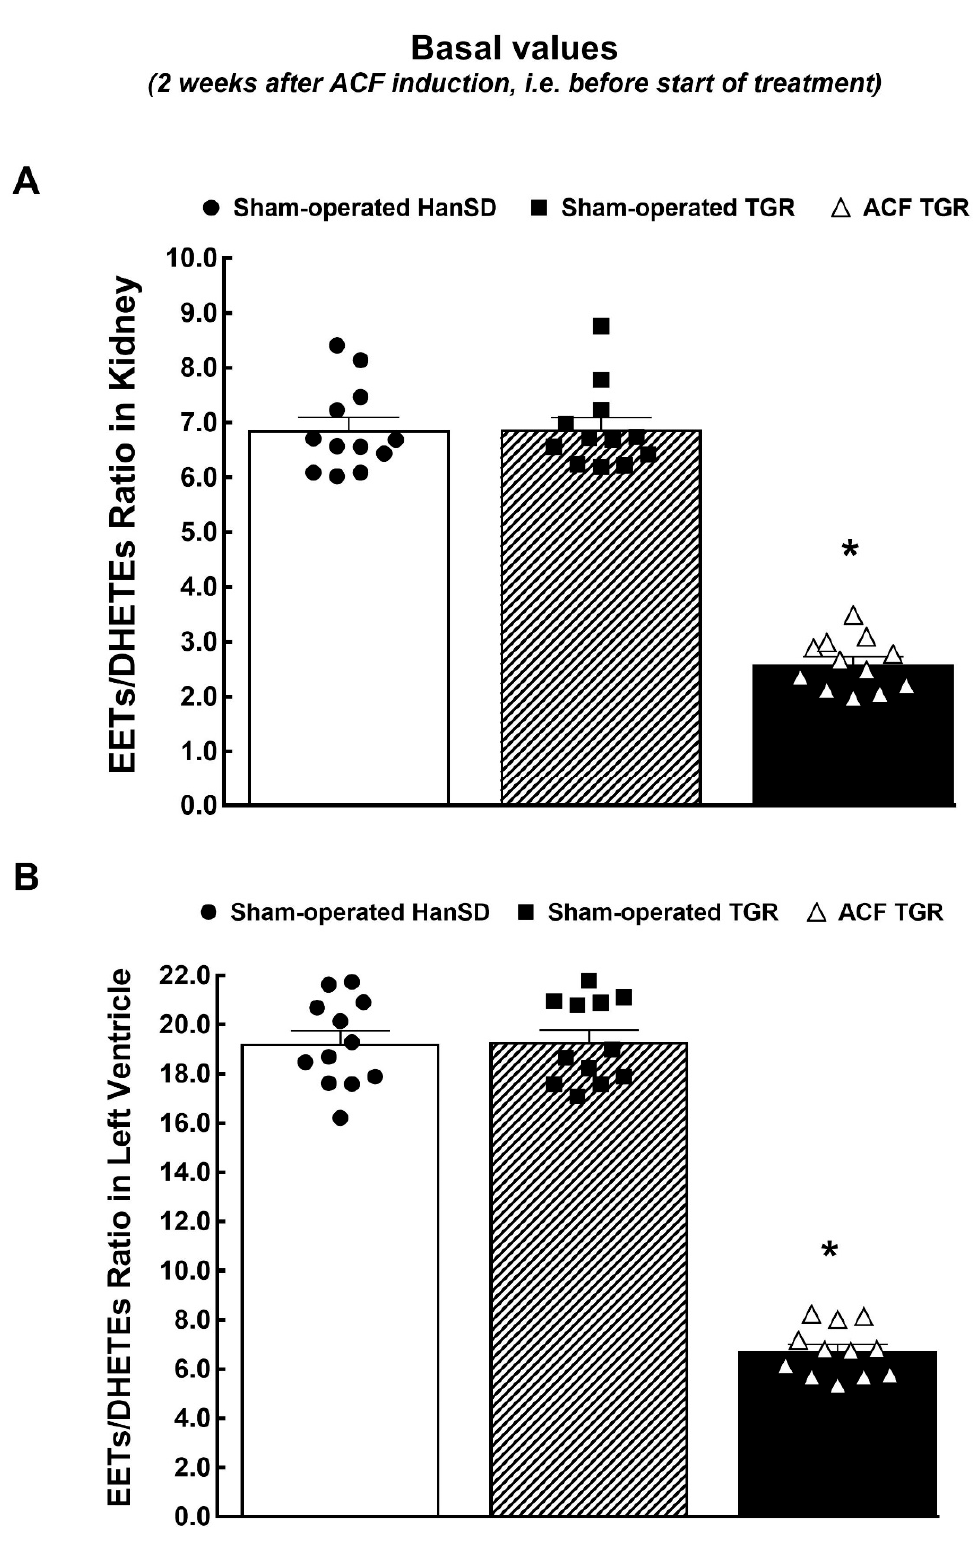
Figure 1. Assessment of kidney and left ventricle tissue availability of biologically active products of cytochrome P-450-dependent epoxygenase pathway of arachidonic acid metabolism. Kidney ( A ) and left ventricle ( B ) ratio in epoxyeicosatrienoic acids (EETs) to dihydroxyeicosatrienoic acids (DHETEs) in sham-operated transgene-negative Hannover Sprague-Dawley rats (HanSD), sham-operated heterozygous Ren-2 transgenic rats (TGR), and TGR rats with aorto-caval fistula (ACF) two weeks after creation of ACF or sham-operation. * p < 0.05 versus sham-operated HanSD rats and sham-operated TGR.